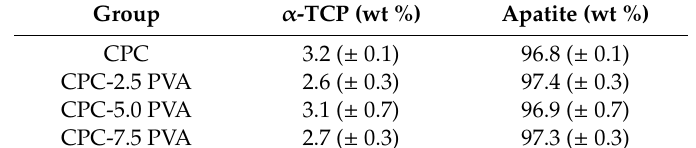
Table 2. Inorganic phase composition of the cements (average ± standard deviation).